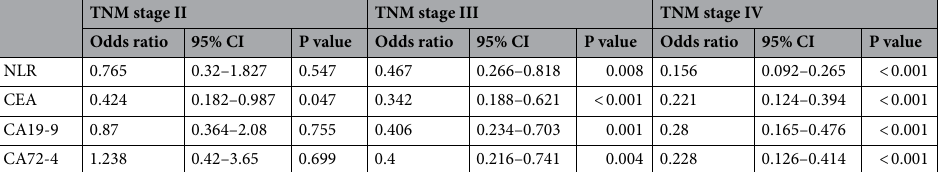
Table 5. Multivariate multiple logistic regression analyses of variables for GC metastasis. For multiple logistic regression analyses the reference category is TNM stage I. The reference of NLR, CEA, CA19-9 and CA72-4 was NLR ≥ 2.91, CEA ≥ 4.34, CA19-9 ≥ 18.69 and CA72-4 ≥ 6.96. TNM tumor-node-metastasis, NLR neutrophil–lymphocyte ratio, CEA carcinoembryonic antigen, CA19-9 carbohydrate antigen 19-9, CA72-4 carbohydrate antigen